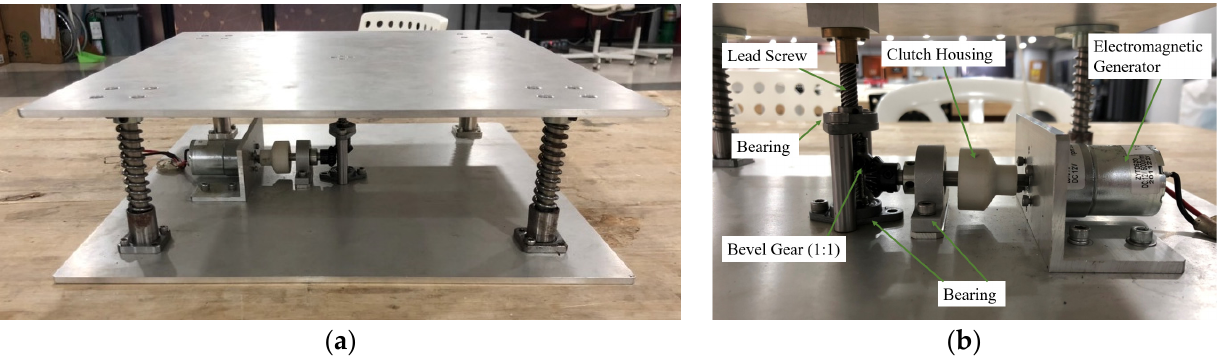
Figure 9. Genpath V2 design . ( a ) Photograph of Genpath V2; ( b ) Photograph of Genpaht V2 Mechanism. Table 5. Parameter of Genpath V2 .